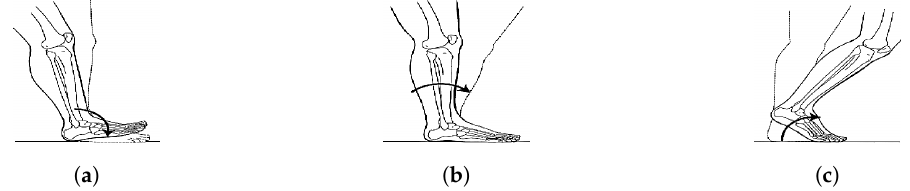
Figure 6. The three foot rockers during stance phase: ( a ) heel rocker , ( b ) ankle rocker , ( c ) forefoot rocker.